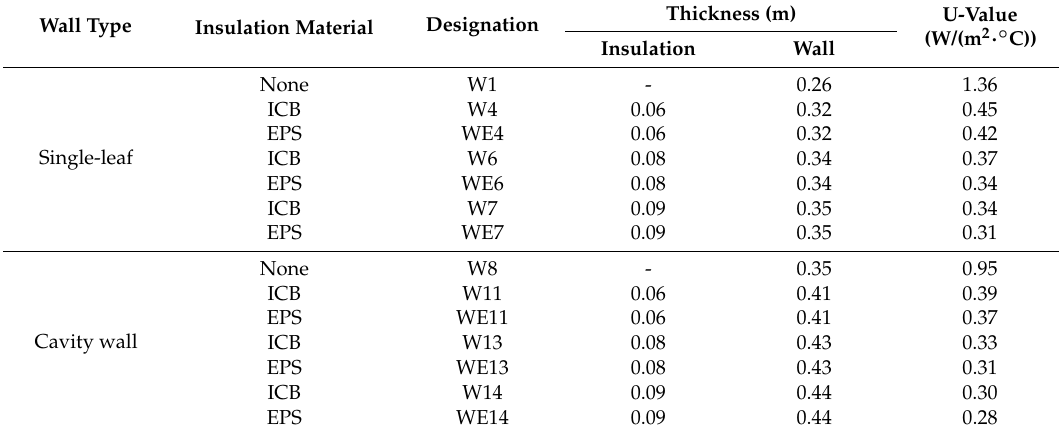
Table 5. Designation, thickness and type of insulation board in the ETICS applied, and thermal performance (U-value) of the wall after